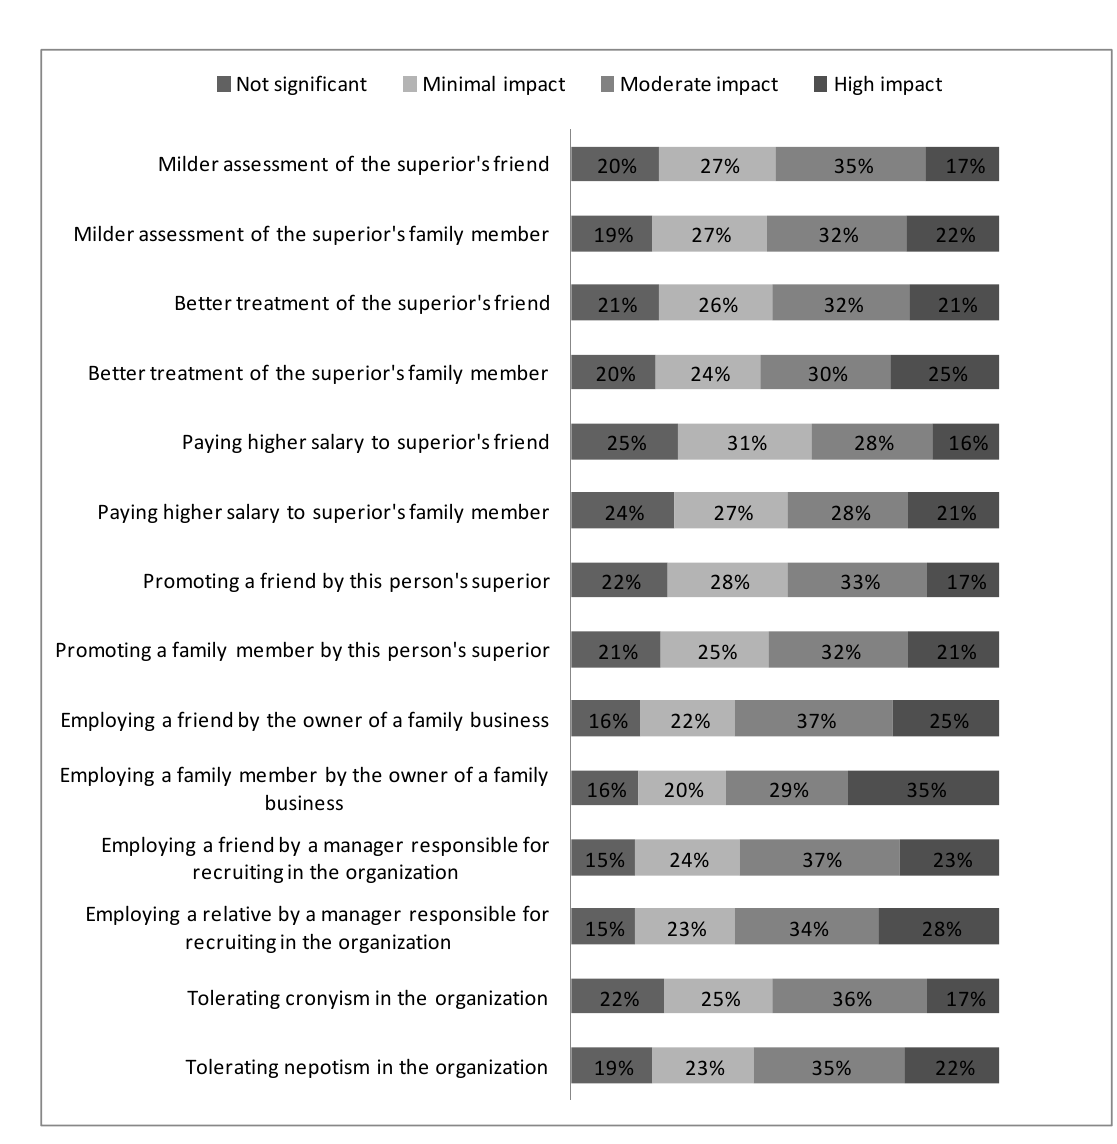
Figure 1. Impact of the Covid pandemic on phenomena related to nepotism and cronyism—opinions of the respondents. Source: authors’ own elaboration.